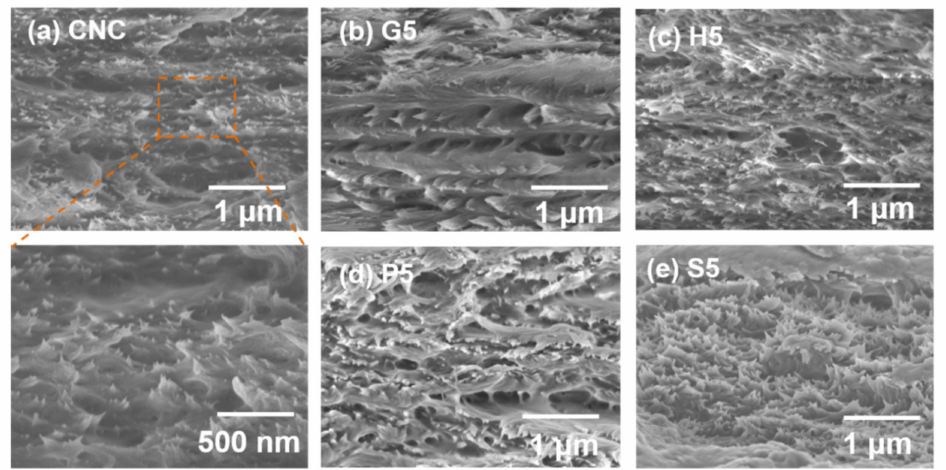
Figure 5. SEM images of the CNC-based films incorporated with the highest proportion of ( a ) CNC (with the enlarged image on bottom left), ( b ) glycine (G5), ( c ) histidine (H5), ( d ) phenylalanine (P5), and ( e ) serine